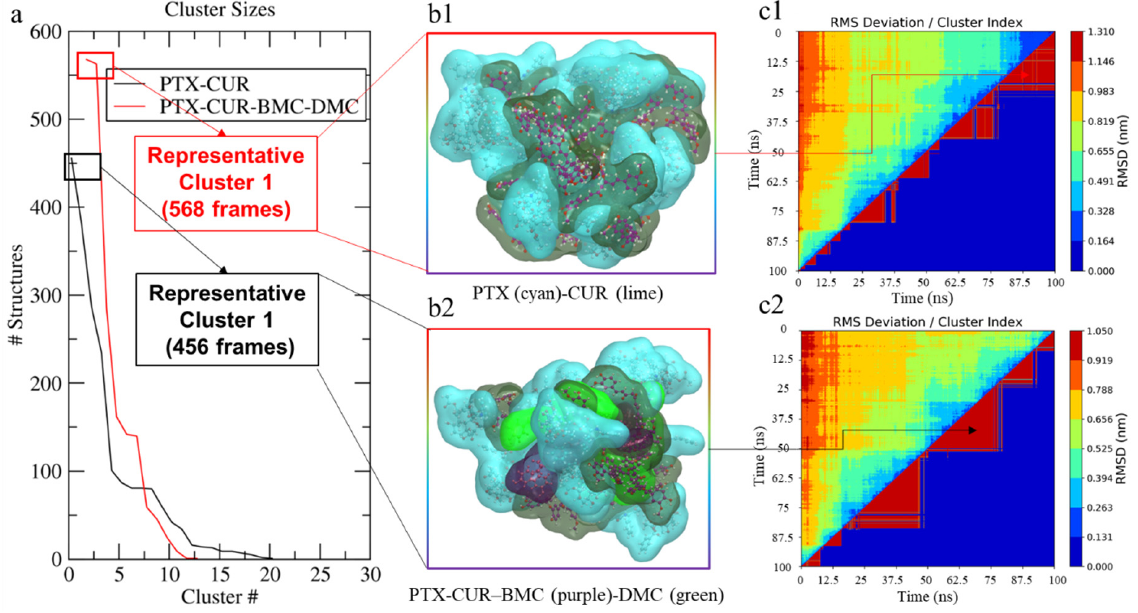
Figure 6. Representative conformation analysis of PTX-CUR and PTX-CUR-BMC-DMC NPs. ( a ) in- dicates the number of NP conformations (y axis) and clusters (x axis) from the total conformations during the whole simulation process; ( b ) describes the representative structure of NPs in water sol- vent (b1 and b2 indicated the PTX-CUR and PTX-CUR-BMC-DMC NPs, respectively); ( c ) denotes the clustering matrix of NPs. PTX, CUR, BMC, and DMC stand for paclitaxel, curcumin, bisdemeth- oxycurcumin, and demethoxycurcumin, respectively (c1 and c2 indicated the PTX-CUR and PTX- CUR-BMC-DMC NPs, respectively).